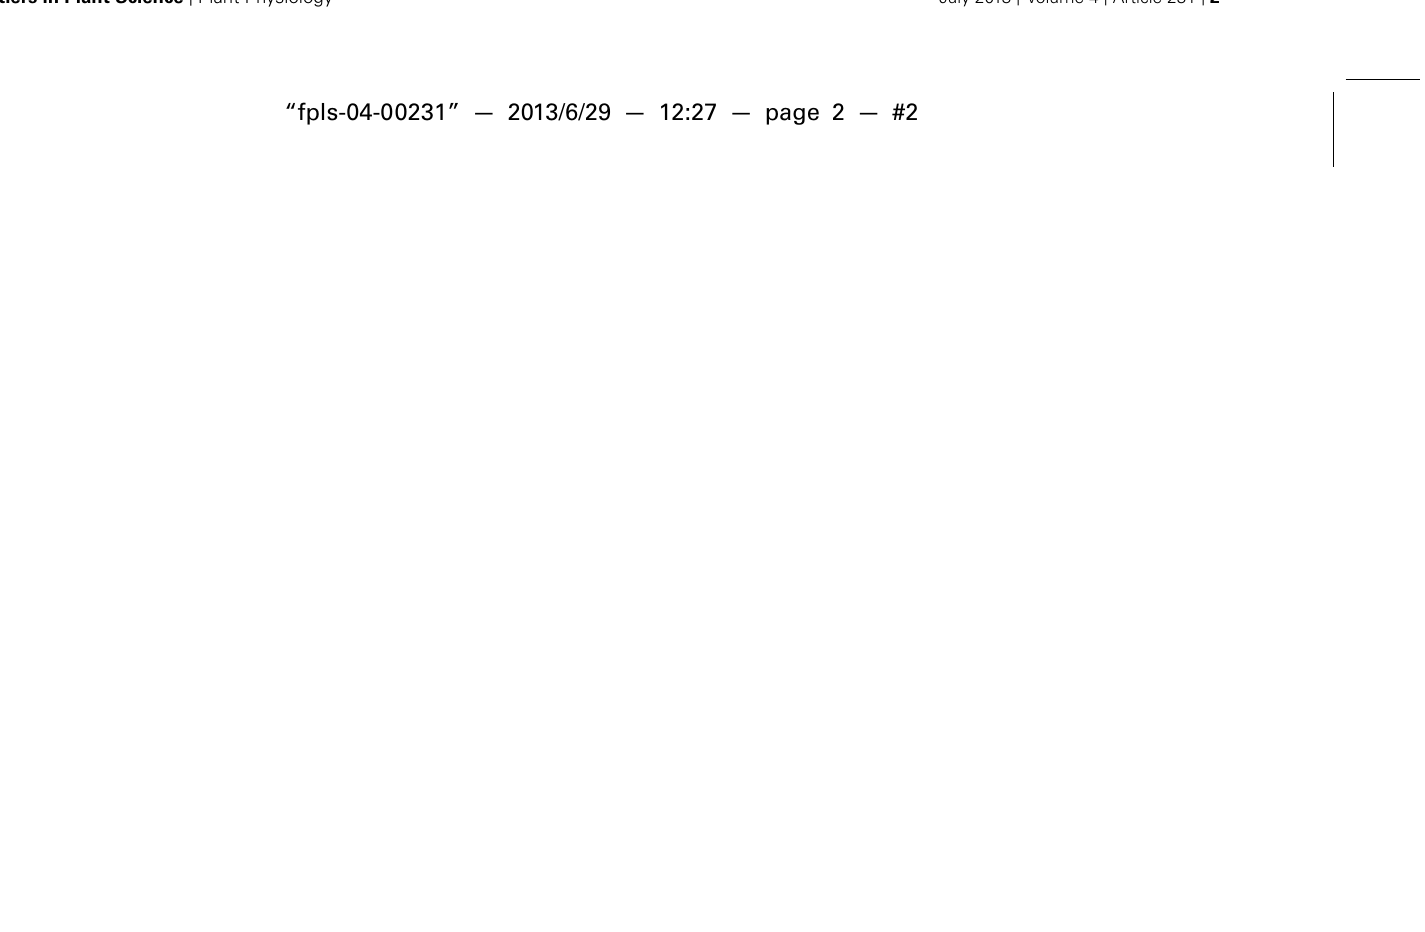
FIGURE 1 | Overview of carbon transport proteins in source leaves. Transport steps in mesophyll cells (MC), parenchyma cells (PC), companion cells (CC), and sieve elements are depicted indicating their respective mode of action. Squares represent antiporters, circles describe facilitators,